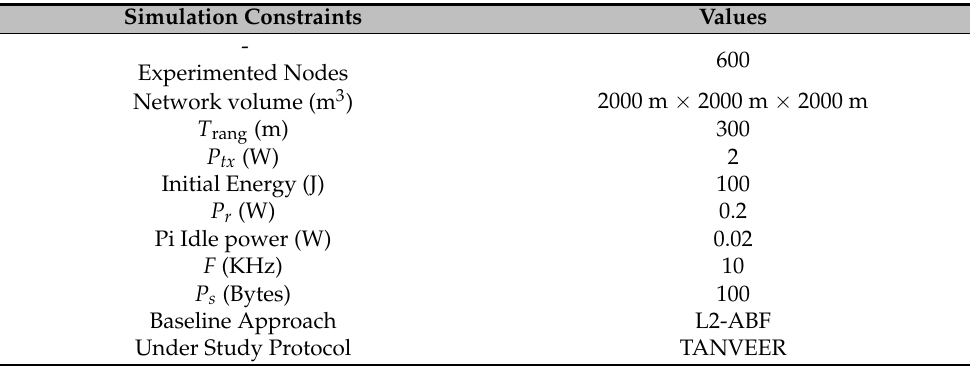
Table 2. Simulation Evaluation